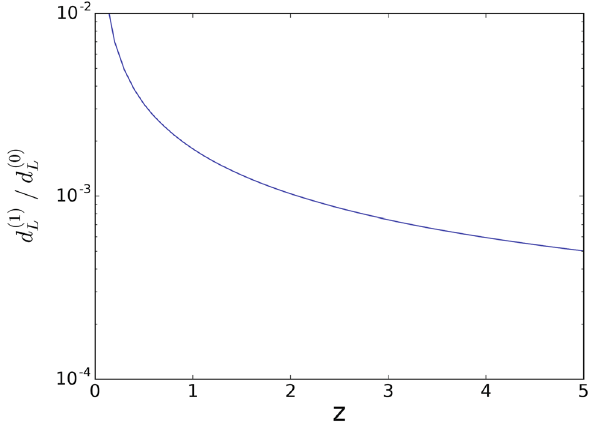
/ d ( 0 ) Fig. 1 The value of d ( 1 ) at different redshift for v 0 = 369 km / s L L [27]. As shown in the picture, the ratio goes very large , even bloom up, at low redshift. That is caused by the fact that the ratio approximate to ( 1 + z ) | v | / z at the limit of z = 0